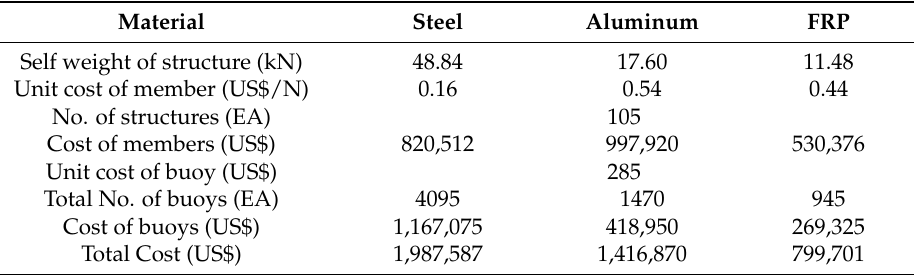
Table 12. Commercial viability evaluation of floating PV generation